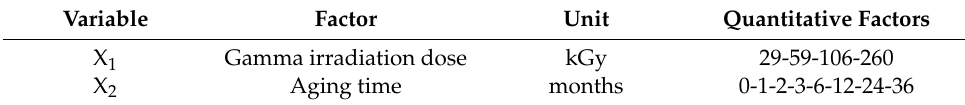
Table 1. The domain of interest for the quantitative variables (X1 and X2) of the experimental design. Variable Factor Unit Quantitative Factors X